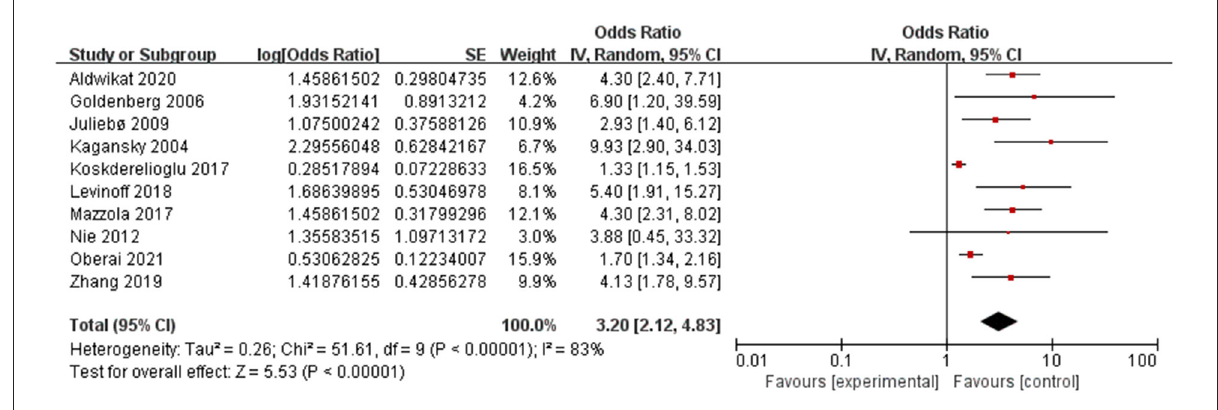
FIGURE6 Forest plot for preoperative cognitive impairment.